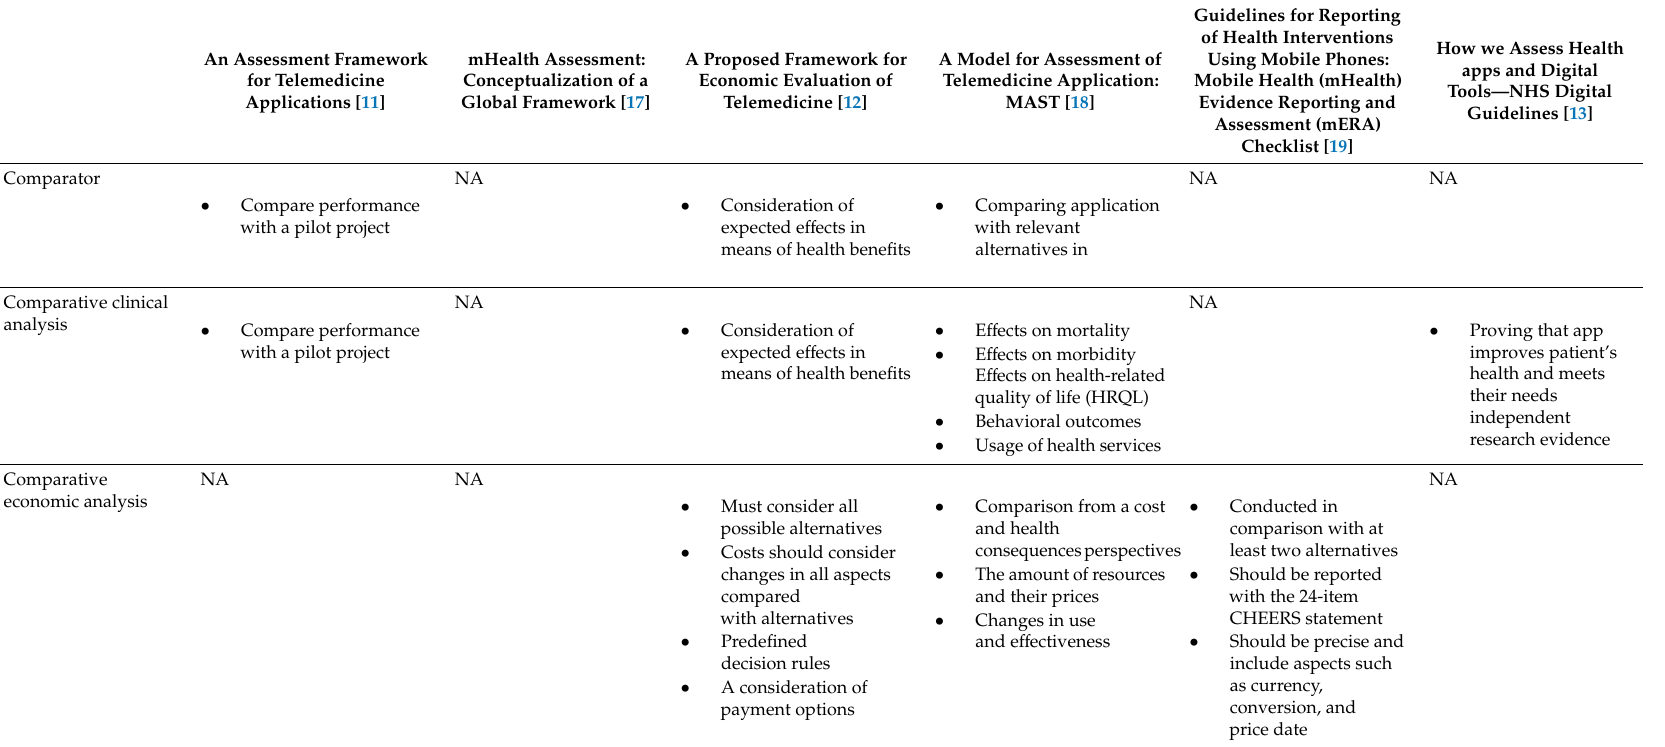
Table A5. Comparative